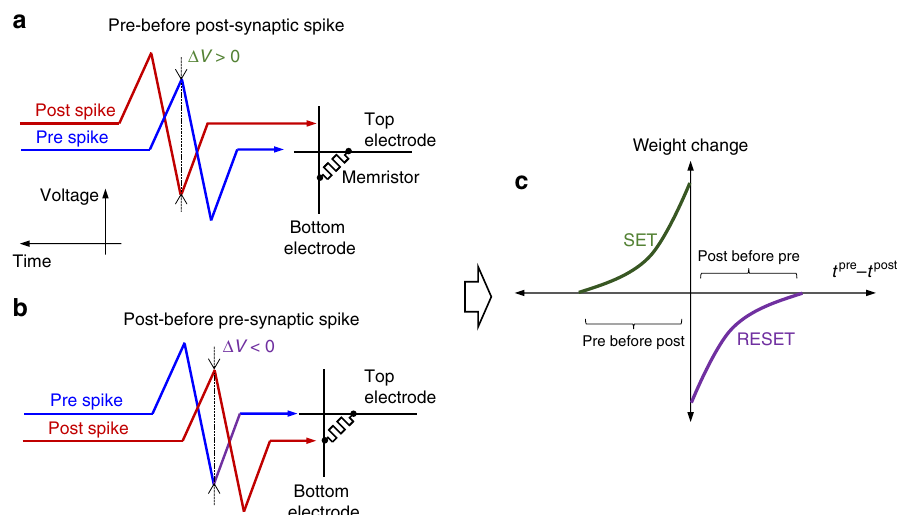
Fig. 1 STDP implementation. Relative timing of the pre- and post-synaptic spikes for performing a potentiation and b depression of the synaptic weight for the memristor-based implementation 11 , resulting in c the speci fi c STDP, which is commonly observed in biology